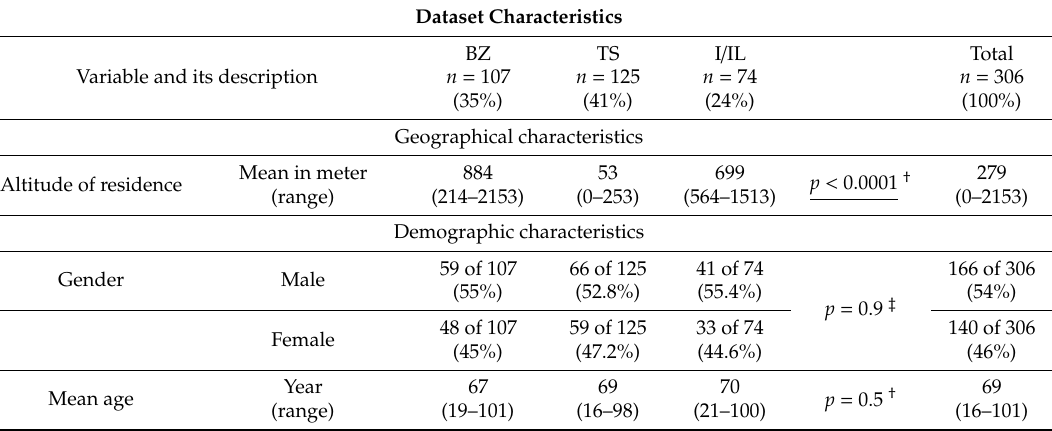
Table 1. Dataset